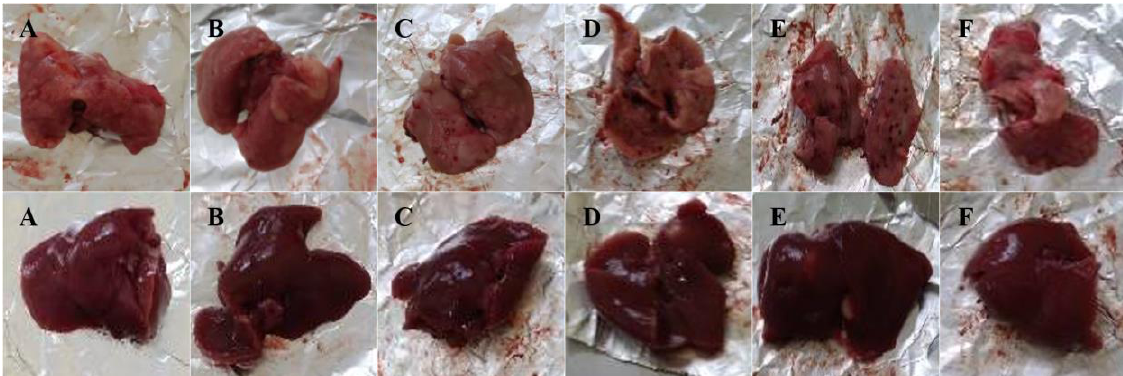
Figure 1. Gross examination of lung and liver. The untreated groups, the cigarette smoke (A), coal smoke (B), and mosquito coil smoke group (C) showed more visible and numerous lesions compared to the treated groups. The worst lesions was found in the mosquito coil smoke group (C). Mosquito coil smoke group (C) has the worst macroscopic view with darker color, many black spots, white membranes, and white mass found. The macroscopic lessions was lesser in the cigarette smoke with gel (D), coal smoke with gel (E), and mosquito coil smoke with gel group (F). The white mass was not found in the groups with gel treatment.